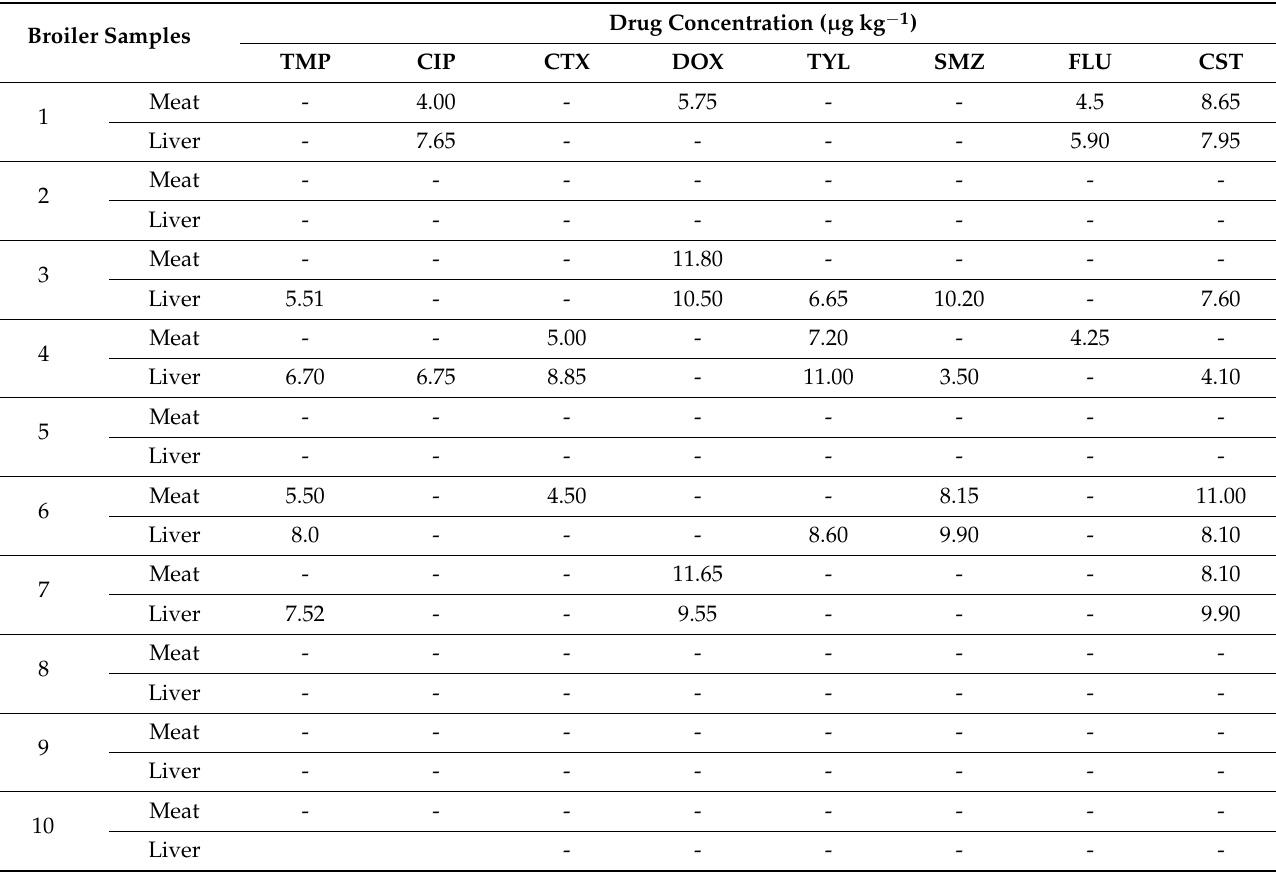
Table 4. Analysis of TMP, CIP, CTX, DOX, TYL, SMZ, FLU, and CST residue in chicken samples by HPLC-UV